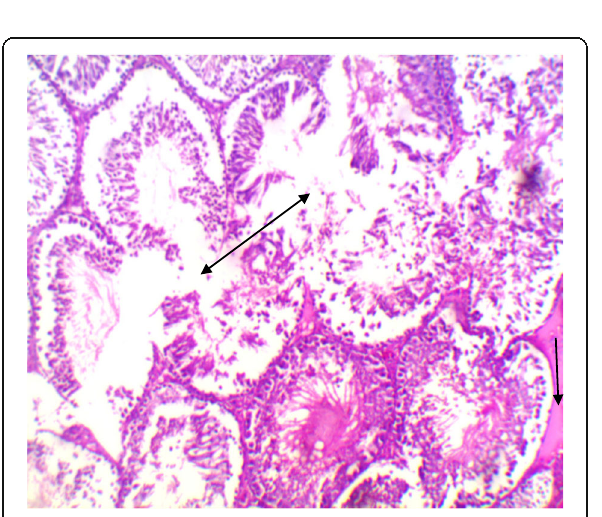
Fig. 22 Photomicrograph of CCl4-treated testis sections showing destruction of walls of seminiferous tubules and oedema (H&E; ×400)